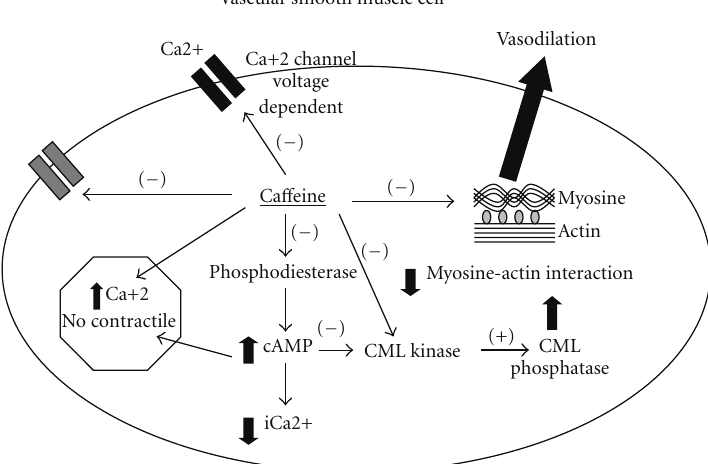
Figure 3: Vasodilation produced by the direct e ff ects of ca ff eine on the VSMC. Ca ff eine inhibits the voltage-dependent Ca 2+ channels and the entrance of calcium to the cytoplasm. In addition, it inhibits the IP3 receptor and increases the “non-contractile Ca 2+ . Due to its antiphosphodiesterase action, there is an accumulation of cAMP, which increases the non-contractile Ca 2+ , diminishes cytoplasmic Ca 2+ (iCa 2+ ), and inhibits Myosin Light Chain Kinase (MLC Kinase). Therefore MLC phosphatase predominates and there is vasodilation. Ca ff eine also directly inhibits MLC Kinase and the actin-myosin interaction.